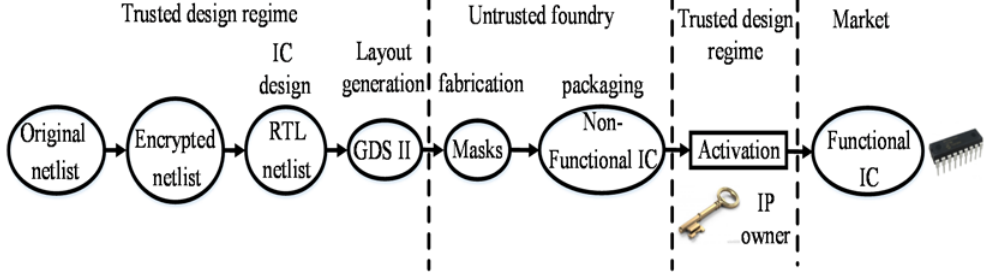
Figure 34. Supply chain security.